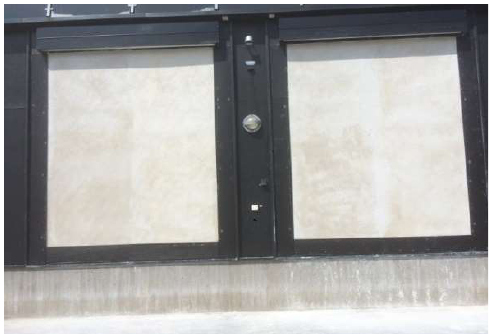
Figure 9. The finished test façades, summer 2017. To the left façade A (lime), to the right façade B (hemp-lime).